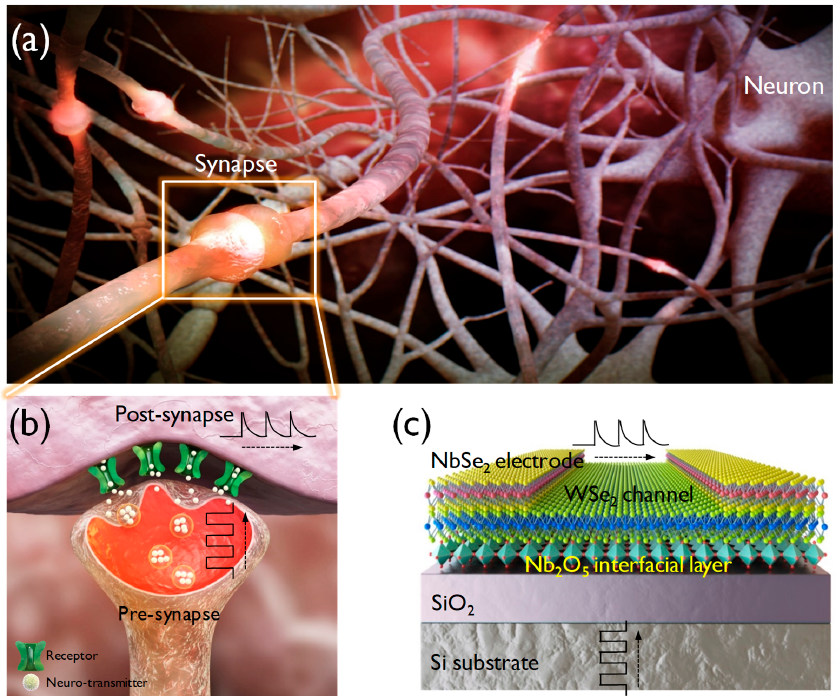
Figure 1. ( a ) Biological neural network consisting of synapses and neurons. ( b ) Operational mechanism of the transmission of an input stimulus from pre-synapse to post-synapse. ( c ) Artificial synapse transistor comprised by vertically stacked NbSe 2 /WSe 2 /Nb 2 O 5 /SiO 2 /p+ Si, mimicking the function of bio synapse.